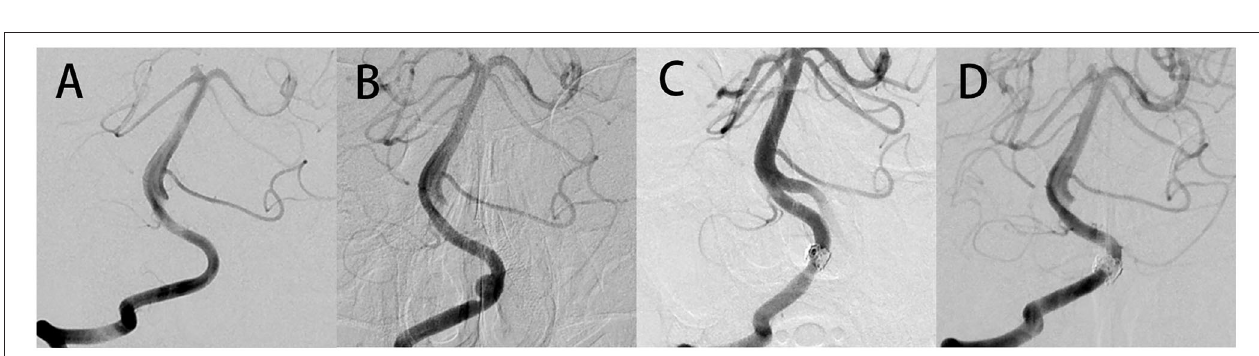
FIGURE 2 | No abnormalities were found in the right VA at the time of 5 months after initial treatment (A) . Follow-up imaging 14 months postoperatively showed a segmental dilatation and narrowing of the right VA, which suggested that a de novo VADA occurred (B) . Stent-assisted coil embolization therapy was performed to occlude this de novo VADA (C) . Angiography at 20 months follow-up after surgery revealed a complete occlusion of the aneurysm (D)